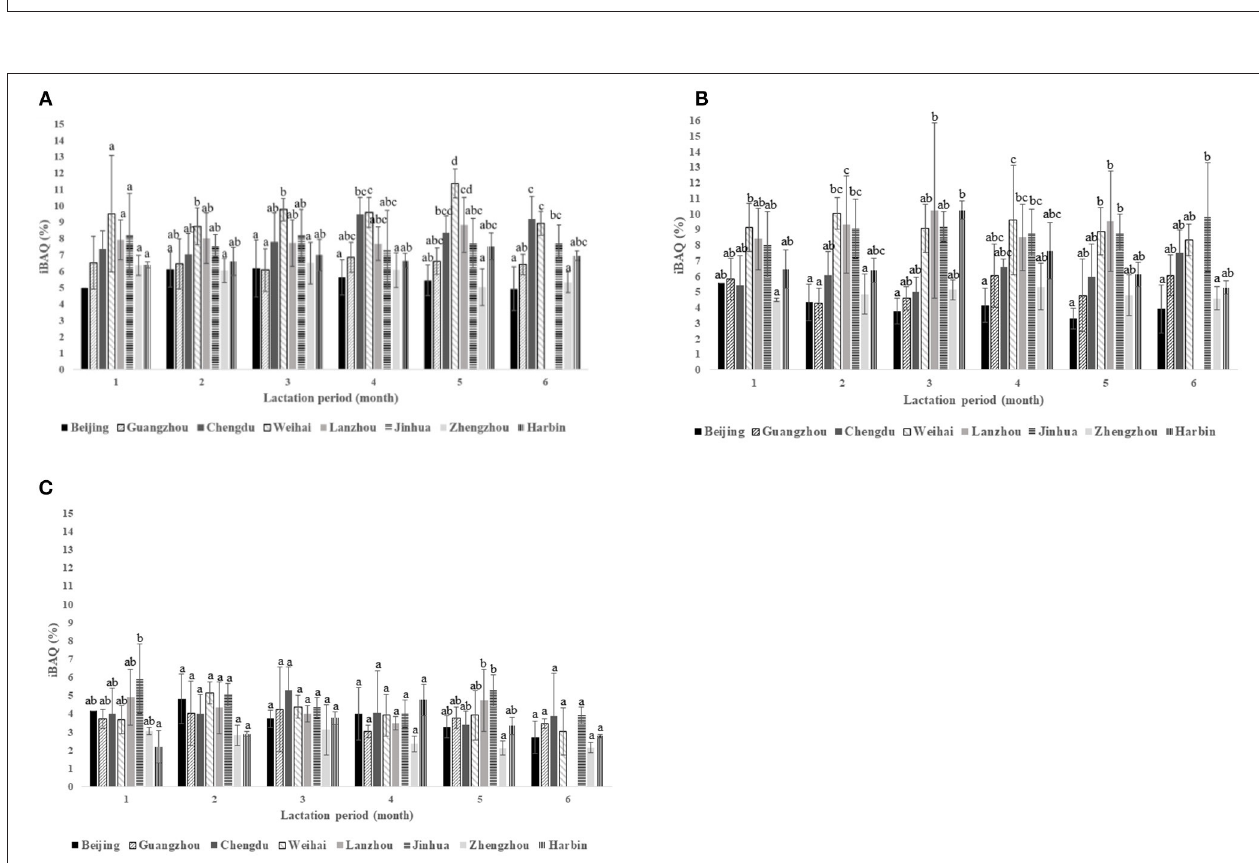
FIGURE 5 | The summed intensities of GO biological process in the terms of: (A) platelet degranulation; (B) innate immune response, and (C) triglyceride metabolic process periods showed the most varied intensities values among the cities.